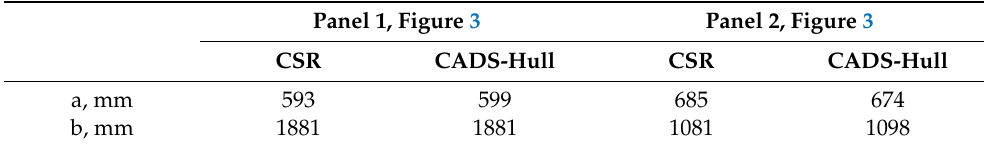
Figure 4. Panels for comparing reduction methods (numbers show the lengths of each side in mm). Table 1. Comparison of the reduced plate